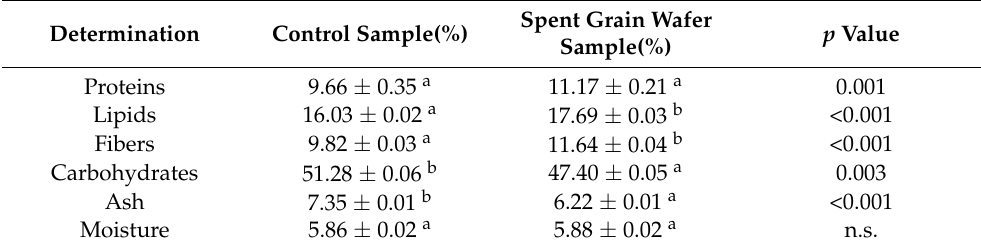
Table 3. Proximate analysis of spent grain